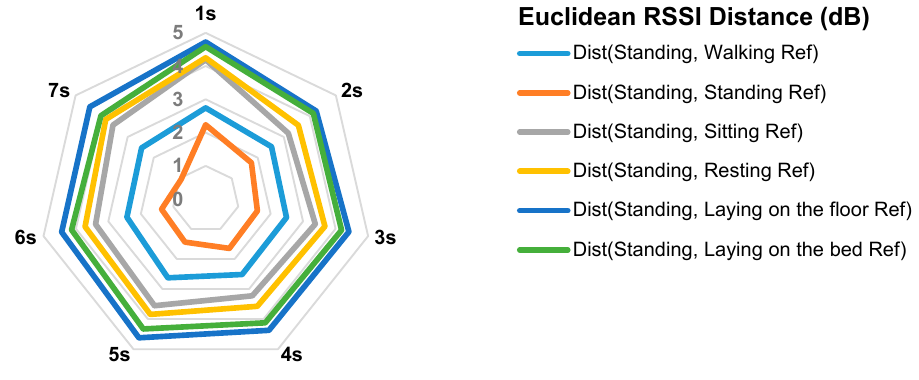
Figure 5. System performance for standing over a stipulated timeframe.